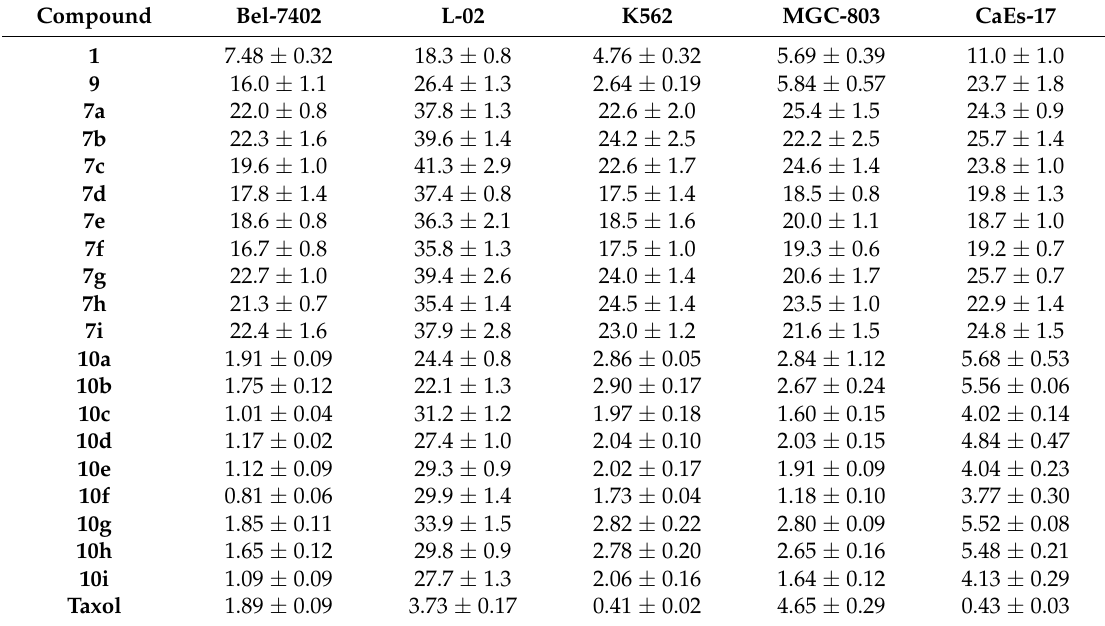
Table 1. The antiproliferative activity (IC 50 a µ M) of synthetic hybrids 10a – i against selected cell lines b .